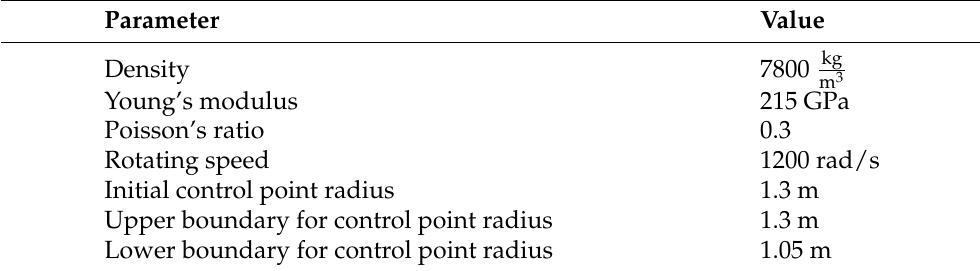
Table 1. Material properties and parameters used in the